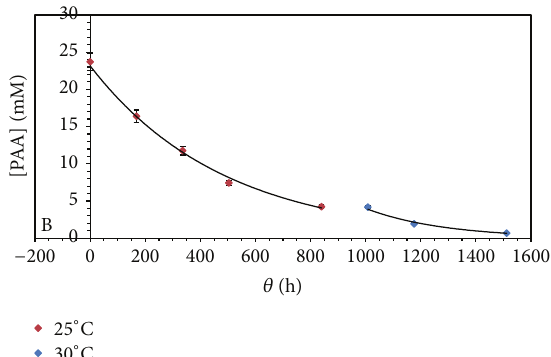
Figure 5: Variation of the initial concentration of 2.22 mmolL −1